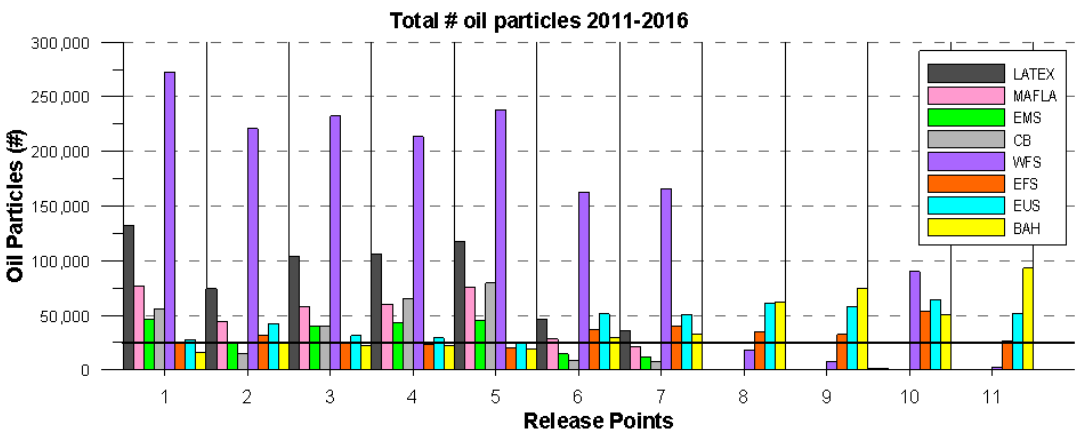
Figure 16. Total number of oil Lagrangian elements (all release points in Figure 1) detected in the continental shelf areas (Figure 1a and Figure 15; Eastern Mexico Shelf: EMS; Louisiana and Texas Shelf: LATEX; Mississippi, Alabama and Florida Shelf: MAFLA; Western Florida Shelf: WFS; Campeche Bank: CB; Eastern Florida Shelf: EFS; Eastern US Shelf: EUS; Bahamas Shelf: BAH) for the 2011–2016 period. The threshold of 25,000 oil elements is marked with a horizontal solid black line.